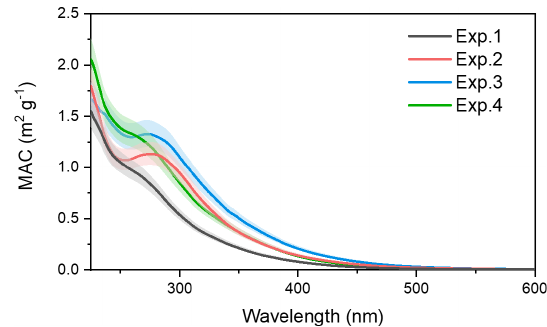
Figure 8. The MAC over the range of 230–600nm for the toluene SOA formed under different experiment